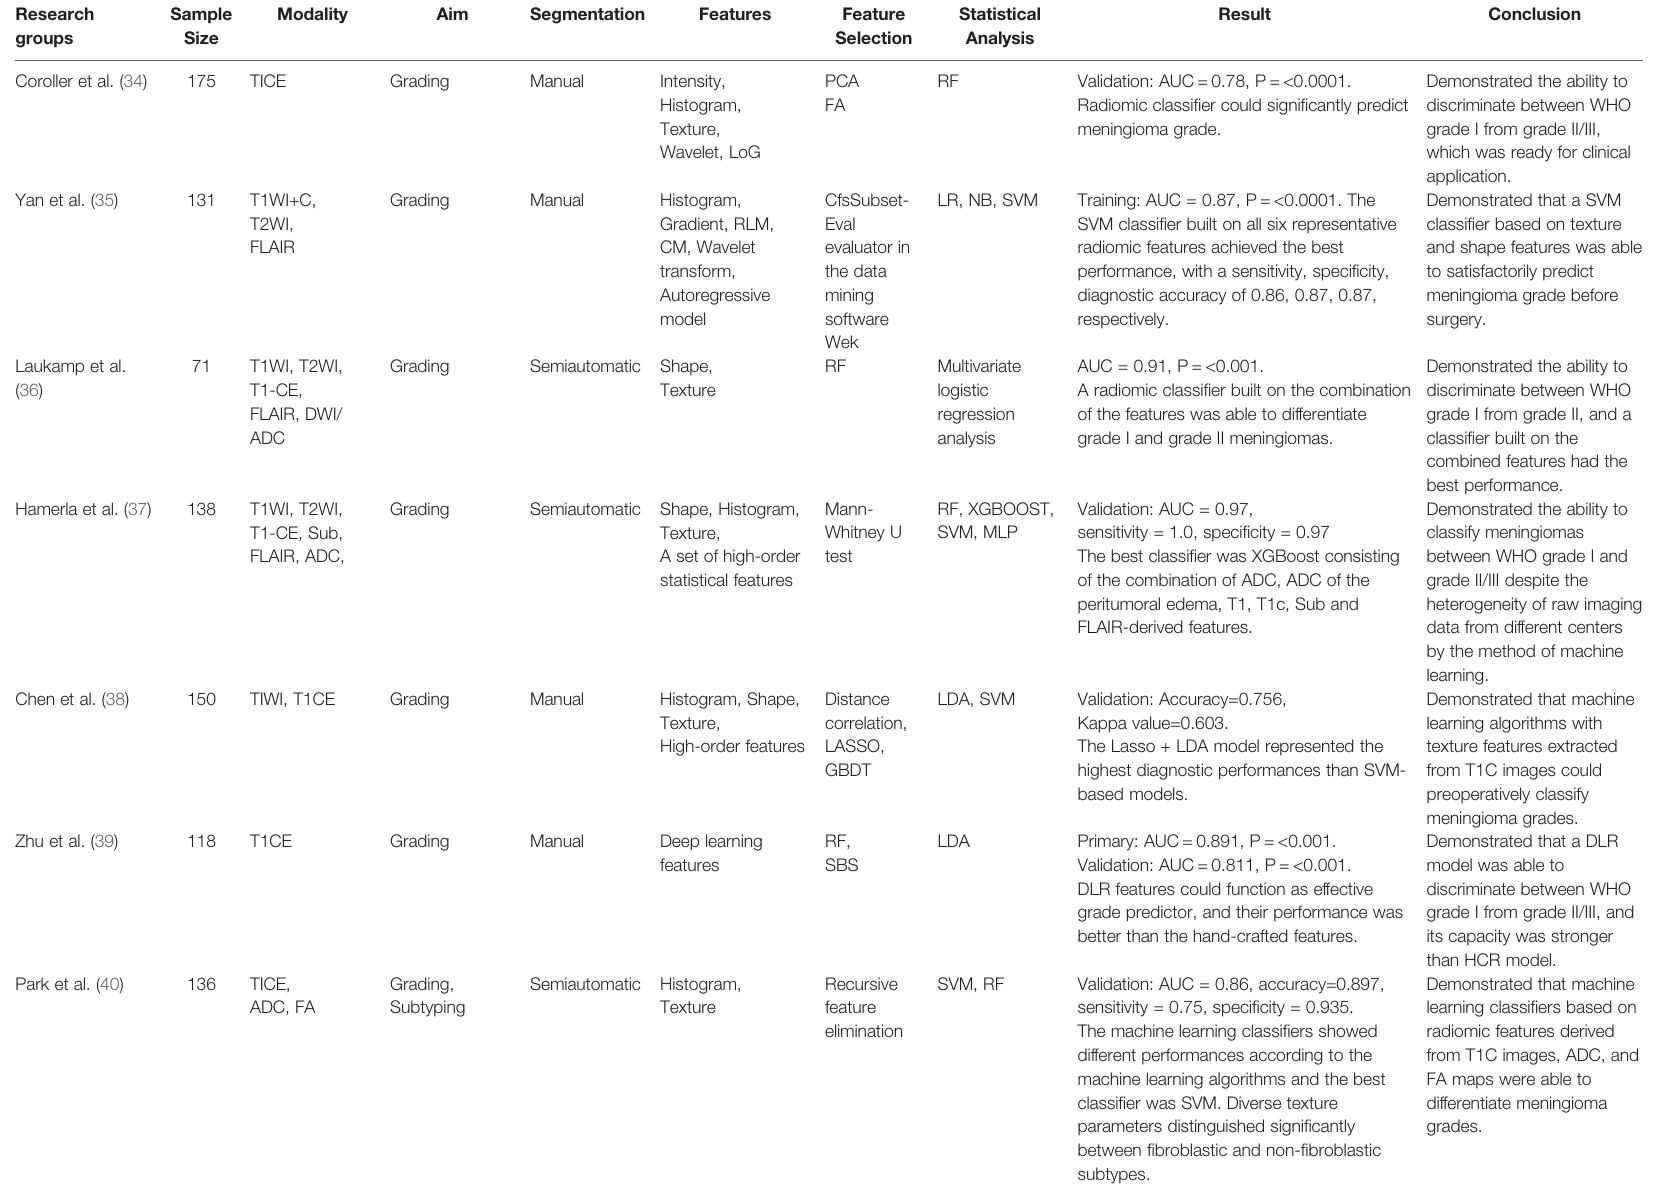
TABLE 1 | Summary of previous reported application of radiomics in